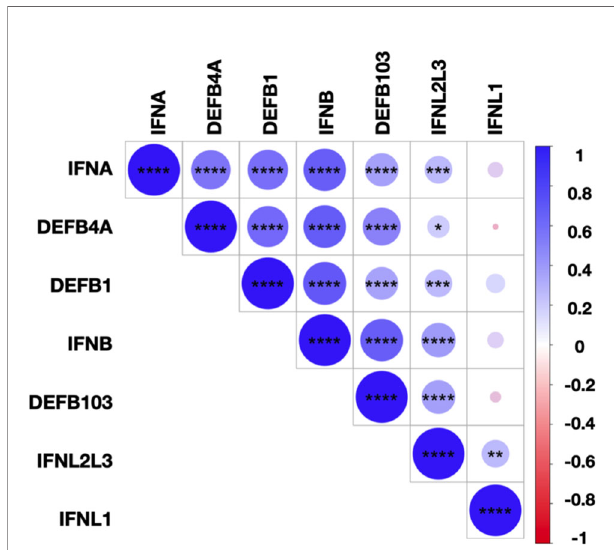
FIGURE 5 | Correlations between IFN-I/-III and hBDs transcript levels. Correlation matrix between IFN-I ( IFNA , IFNB ), IFN-III ( IFNL1 , IFNL2/L3 ), and hBD1-3 ( DEFB1 , DEFB4A , DEFB103 ) transcripts levels in SARS-CoV-2- infected subjects. The levels of correlation between the transcripts are ordered by hierarchical clustering. The scale represents the correlation coef fi cient between the different transcripts. The signi fi cance of the correlations was calculated using Spearman ’ s correlation test. *p < 0.05; **p < 0.01; ***p < 0.001; ****p <